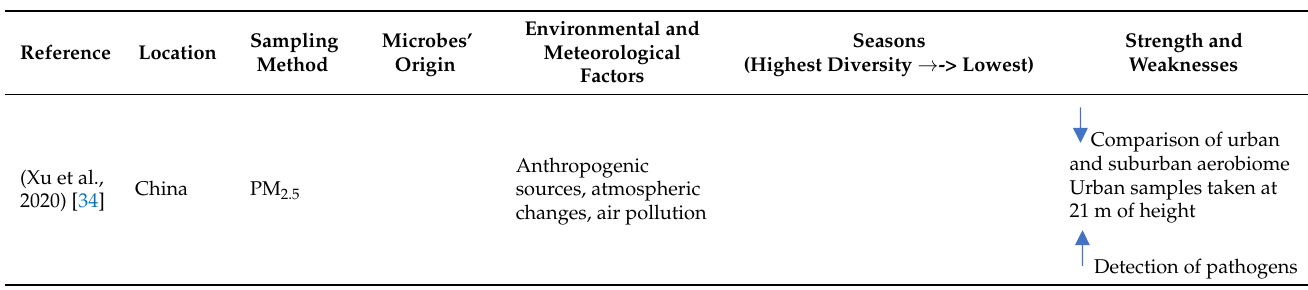
Table 2. Parameters that affect the microbial community: microorganisms’ emission sources, environmental and meteorological factors, and the season in which the alpha diversity was higher reported by each selected paper. Strength (indicated with ) and criticalities ( ) for each paper are